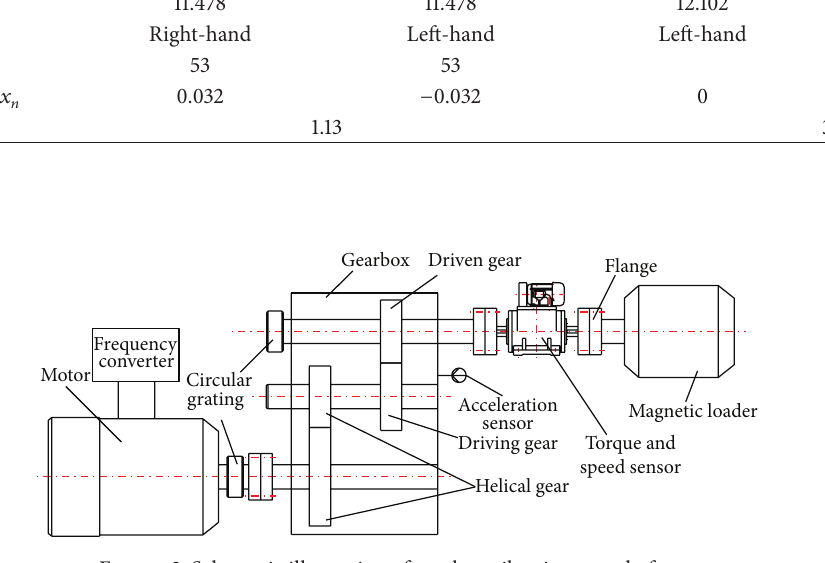
Figure 2: Schematic illustration of gearbox vibration test platform.